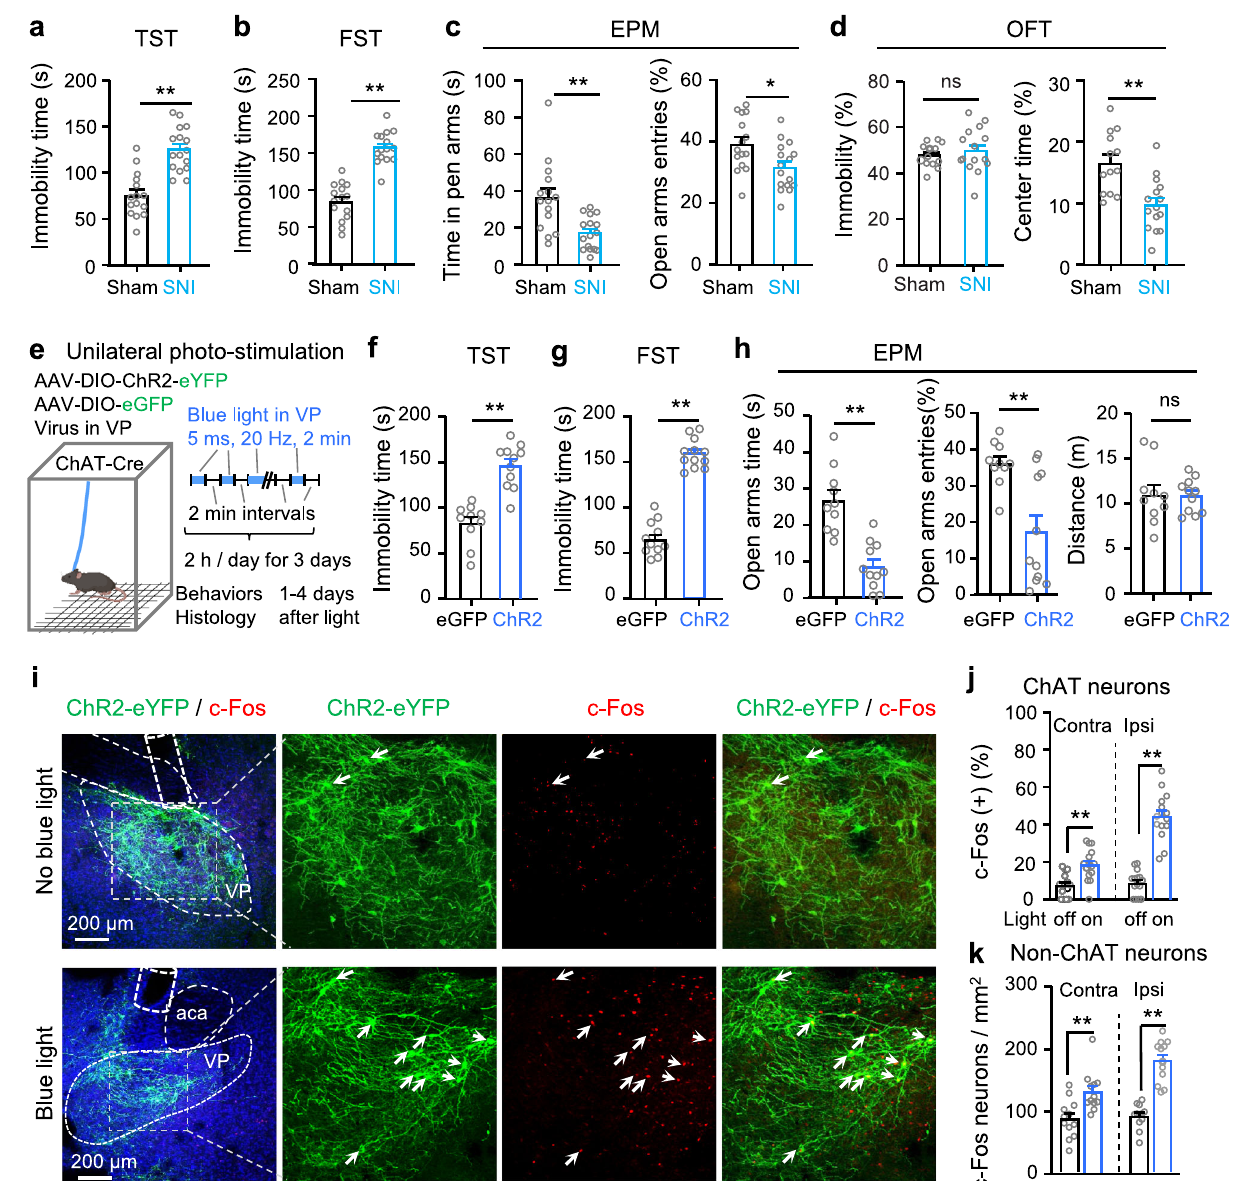
Fig. 5 | Repetitive optogenetic stimulation of VP ChAT neurons causes depression- and anxiety-like behaviours. a – d Tests for emotion-like behaviours were conducted in Sham mice ( n =13 – 15) and SNI mice ( n =15 – 20). a Tail suspen- sion test (TST). t =8.48, df=28, P <0.0001. b Forced swim test (FST). t =5.79, df=29, P <0.0001. c Elevatedplusmaze(EPM).Timeinopenarms: t =3.55,df=29, P =0.0013. Open-arm entries: t =2.57, df=29, P =0.016. d Open fi eld arena (OFT). Immobility: t =0.73, df=26, P =0.47. Time in center: t =3.88, df=26, P =0.0006. e Schematicdiagramforrepetitive(3-day)unilateralphoto-stimulationofVPChAT neurons in ChR2 and eGFP mice. f Immobility time in the TST. t =6.13, df=19, P <0.0001.eGFP: n =10;ChR2: n =11. g ImmobilitytimeintheFST. t =12.80,df=21,